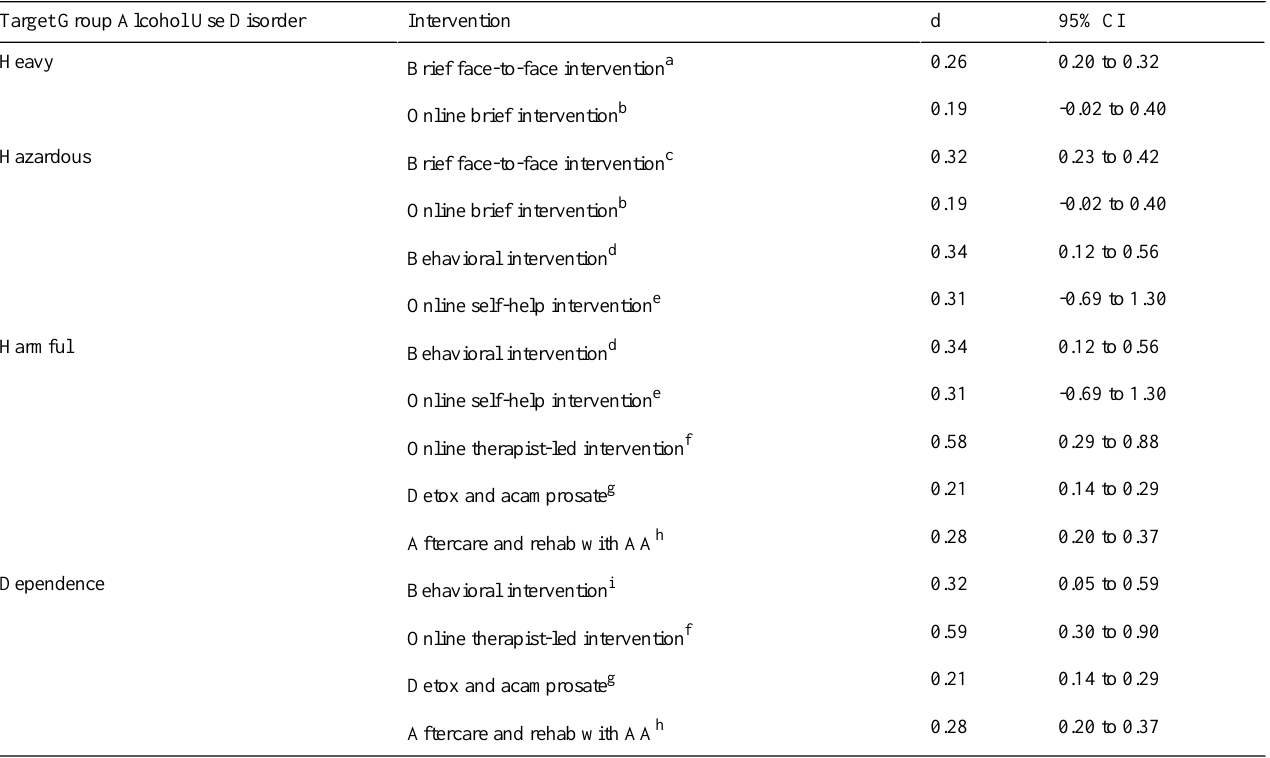
Table 3. Effectiveness of the interventions: standardized mean differences, 95% confidence interval for d (95% CI), difference in pure alcohol intake (mg/day) and